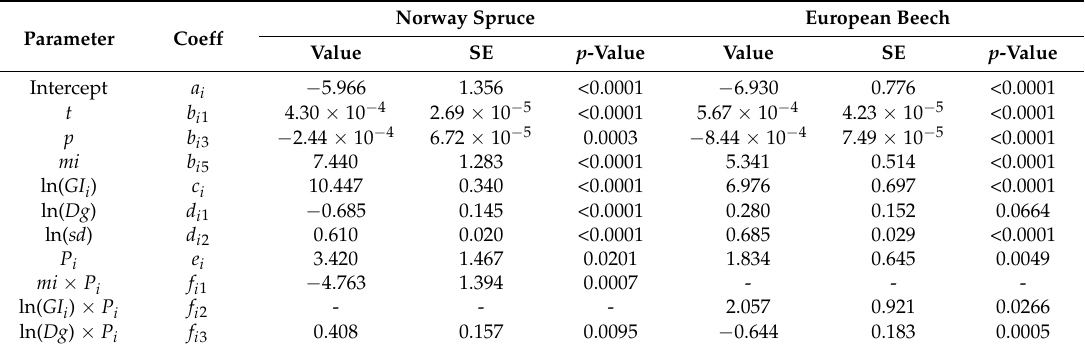
Table 4. Fixed effect parameter estimates for the Norway spruce and European beech growth models using 3P proportions.